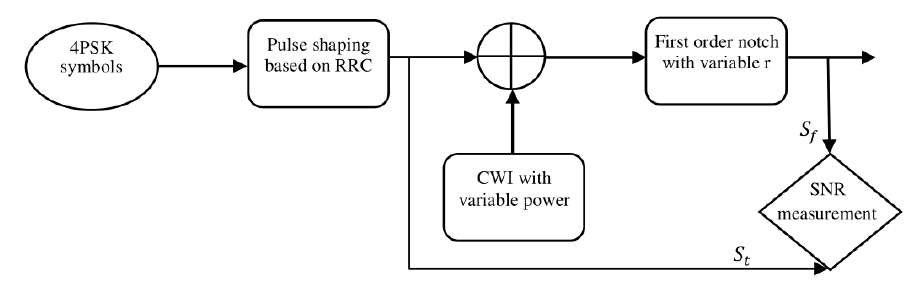
Figure 9. Utilized scenario for optimum (cid:1870) parameter calculation.